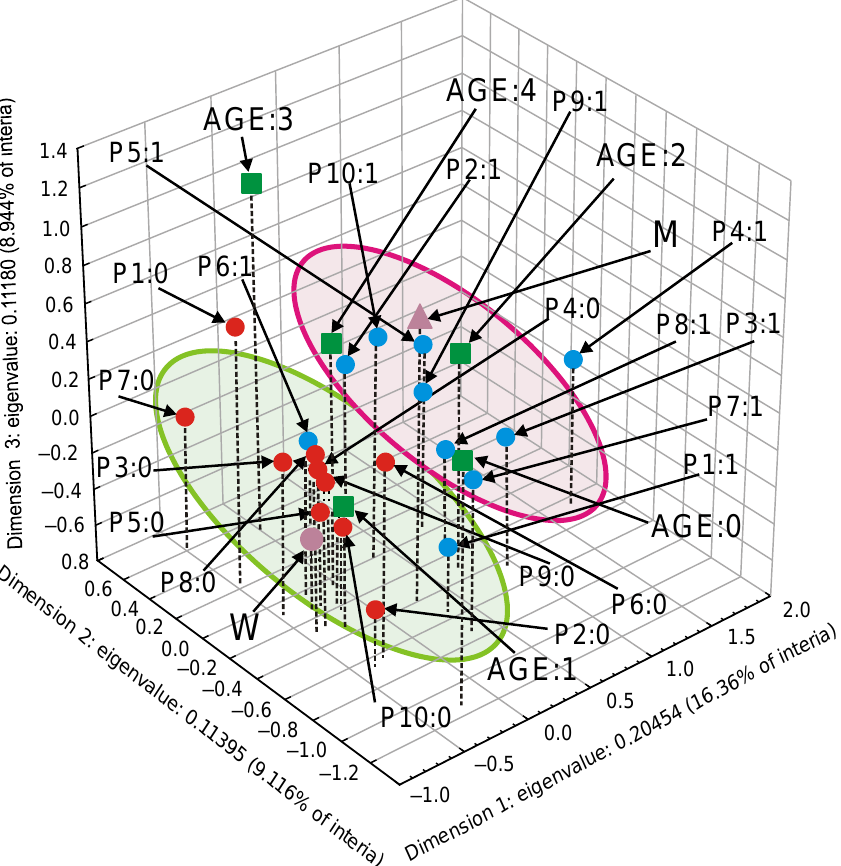
Figure 4. Three-dimensional plot of column coordinates—dimension 1 2 3. Input table (rows × columns): 27 27 Burt Table.